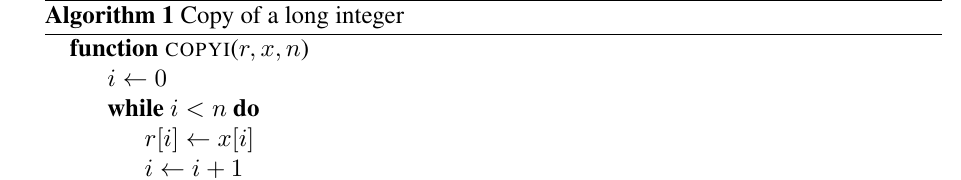
Fig. 1. WhyML transcription of the COPYI function.